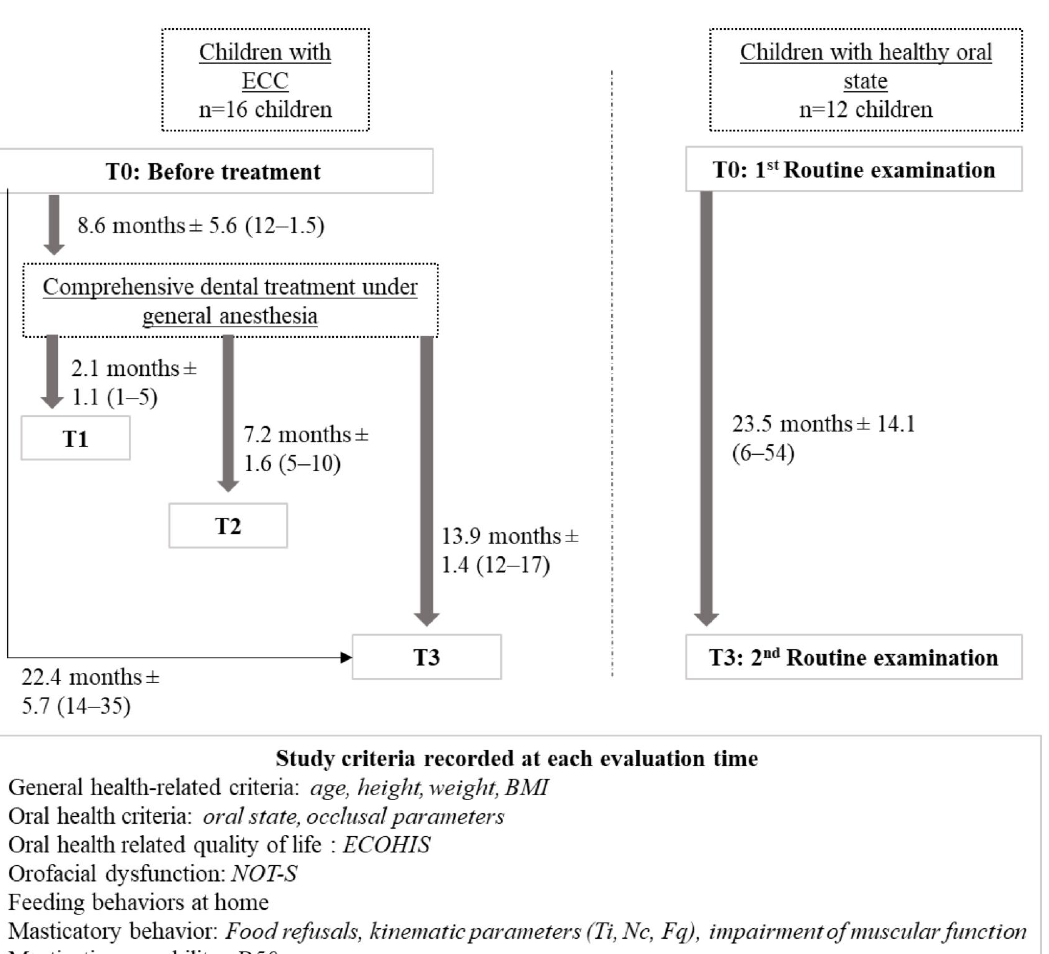
Figure 1. Protocol sequence for both groups of